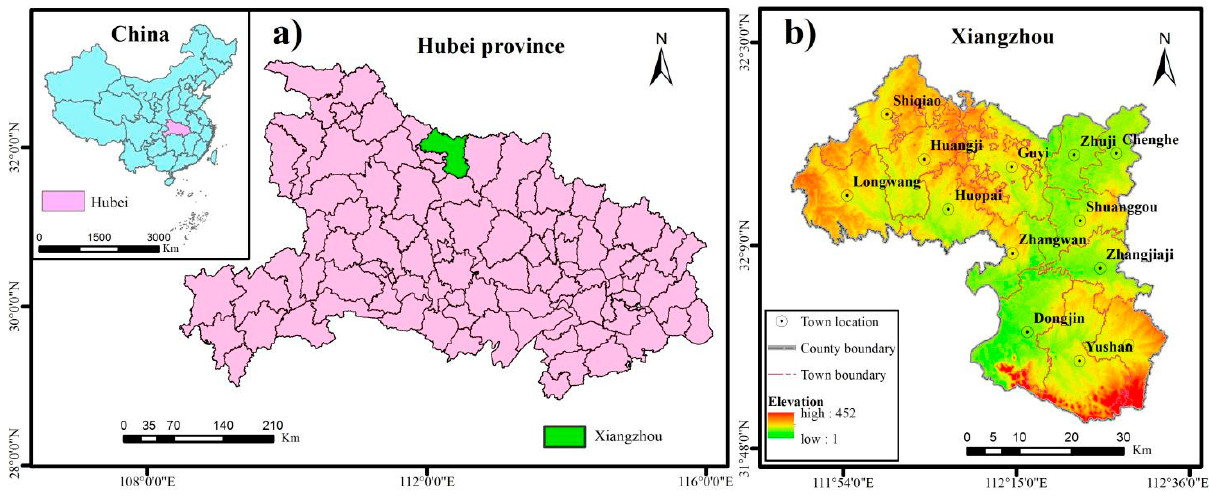
Figure 1. Study area: ( a ) location in Hubei Province, China; ( b ) digital elevation map (DEM) of Xiangzhou.